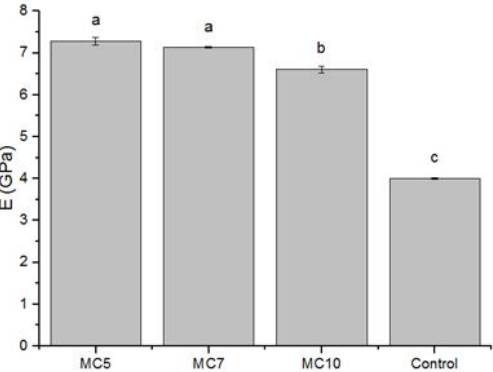
Figure 5. The elastic modulus of the magnetocaloric composites and control sample. Different letters indicate statistical differences between the